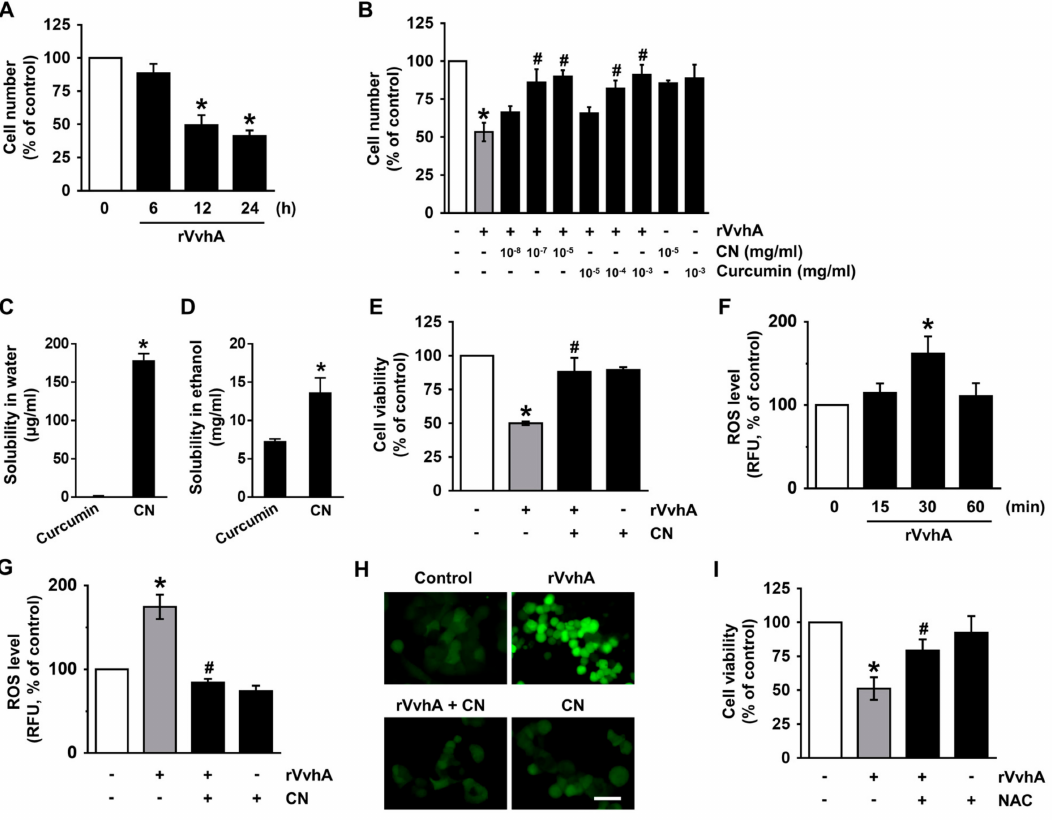
Figure 2. CN has an inhibitory e ff ect on the production of reactive oxygen species (ROS) responsible for cytotoxicity caused by V. vulnificus , VvhA. ( A ) Time responses of cell viability in cell treated with rVvhA is shown. n = 4. * p ≤ 0.01 vs. 0 h. ( B ) Cells were treated with CN (10 − 8 ~10 − 5 mg / mL) or curcumin (10 − 5 ~10 − 3 mg / mL) in the presence of rVvhA for 24 h. The number of cells was determined by cell counting assay. n = 4. * p ≤ 0.01 vs. control. # p ≤ 0.05 vs. rVvhA alone. The solubility of CN in water ( C ) and ethanol ( D ) is shown. n = 5. * p ≤ 0.01 vs. Curcumin ( E ) Cells were treated with CN (10 − 7 mg / mL) and rVvhA for 24 h. Cell viability was determined by EZ-CYTOX kit. n = 3. * p ≤ 0.001 vs. control. # p ≤ 0.01 vs. rVvhA alone. ( F ) The level of ROS in rVvhA-treated cell is shown. n = 3. * p ≤ 0.01 vs. 0 min. ( G ) Cells were incubated with CN and rVvhA for 30 min. The level of ROS production is shown. n = 3. * p ≤ 0.01 vs. control. # p ≤ 0.001 vs. rVvhA alone. RFU, Relative fluorescence units. ( H ) ROS production (green) was visualized by confocal microscopy. Scale bars, 100 µ m (Original magnification × 100). n = 3. ( I ) Cells were pretreated with NAC (10 µ M) for 30